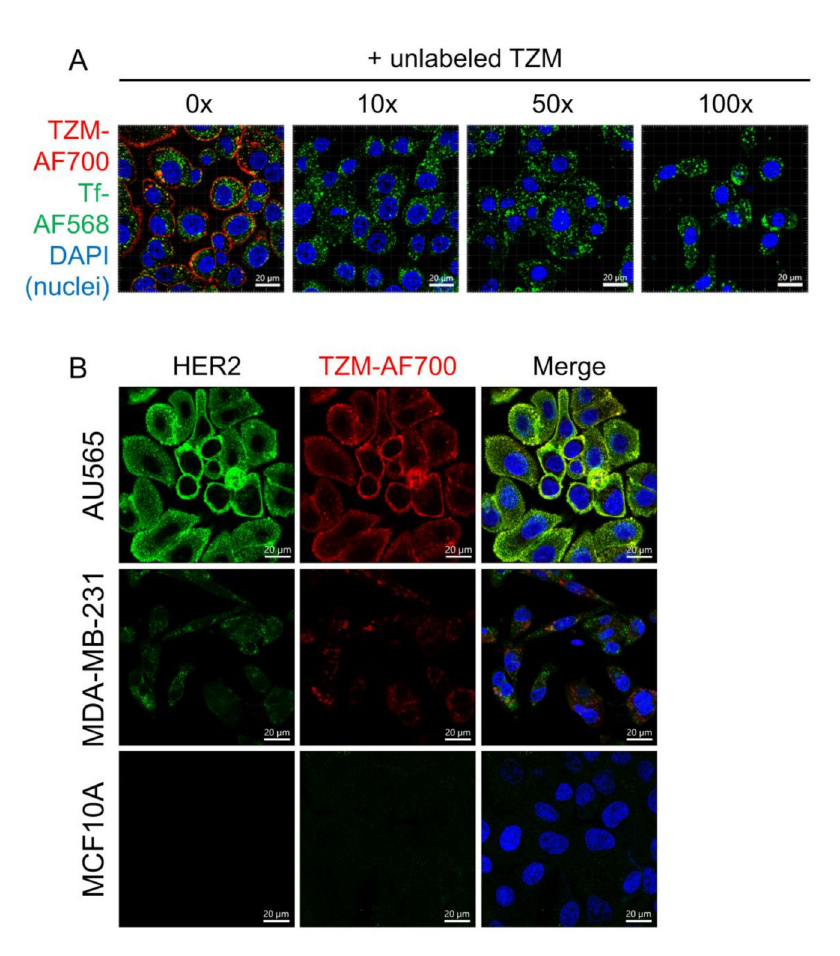
Figure 2. Comparison of intracellular uptake of TZM–AF700 into HER2-positive and HER2-negative cell lines. ( A ) To test the specificity of HER2-mediated TZM–AF700 binding and